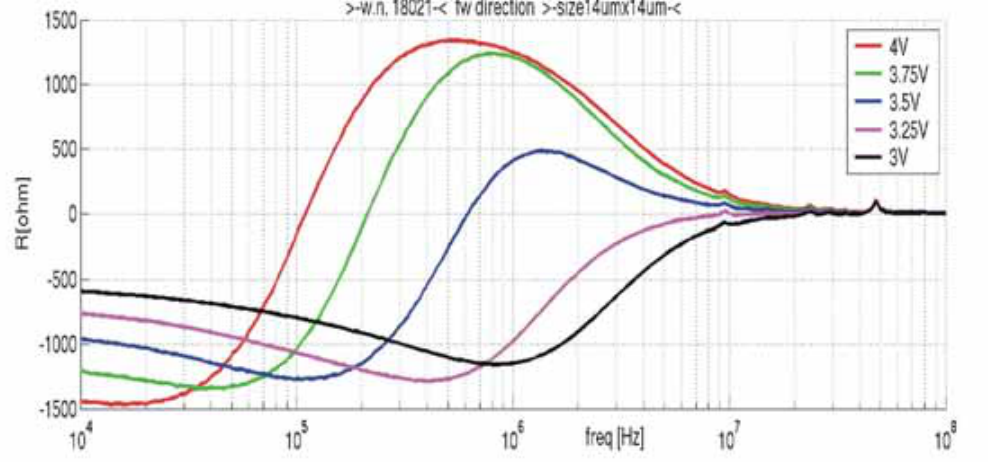
Figure 10. Impedance measurements of a Gunn diode with spacer layers at different supply